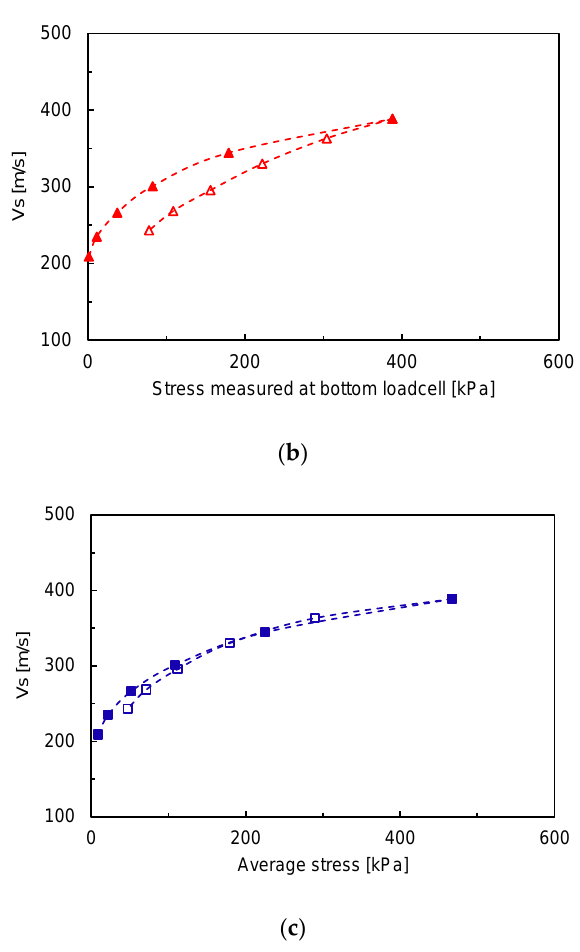
Figure 5. Variation in shear wave velocities for Dr = 80% and D/H = 1 along: ( a ) the applied stress at top; ( b ) applied stress at the bottom; and ( c ) the average applied stress. The solid and hollow markers denote the loading and unloading steps, respectively.